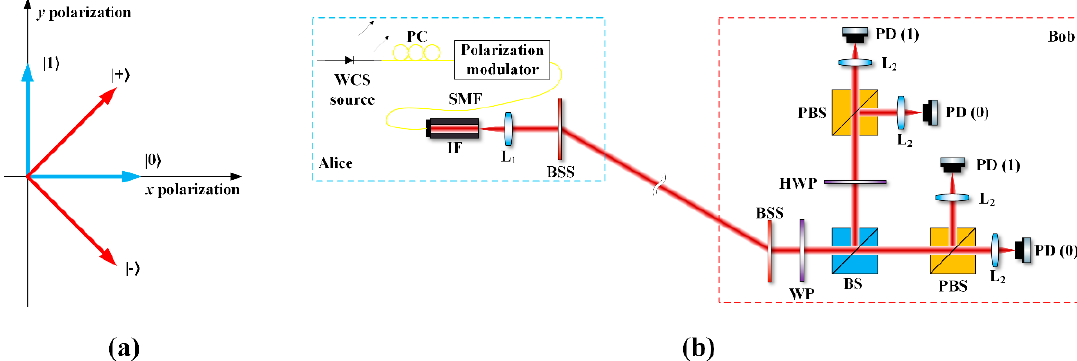
Figure 20. ( a ) The four states that applied and ( b ) the schematic of a polarization based BB84 protocol. (WCS source: weak coherent state source; PC: polarization controller; SMF: single mode fiber; IF: input fiber; L1: collimator; BSS: beam steering system; WP: wave plate; HWP: half-wave plate; BS: beam splitter; PBS: polarization beam splitter; L2: focusing lens; PD: photodetector).